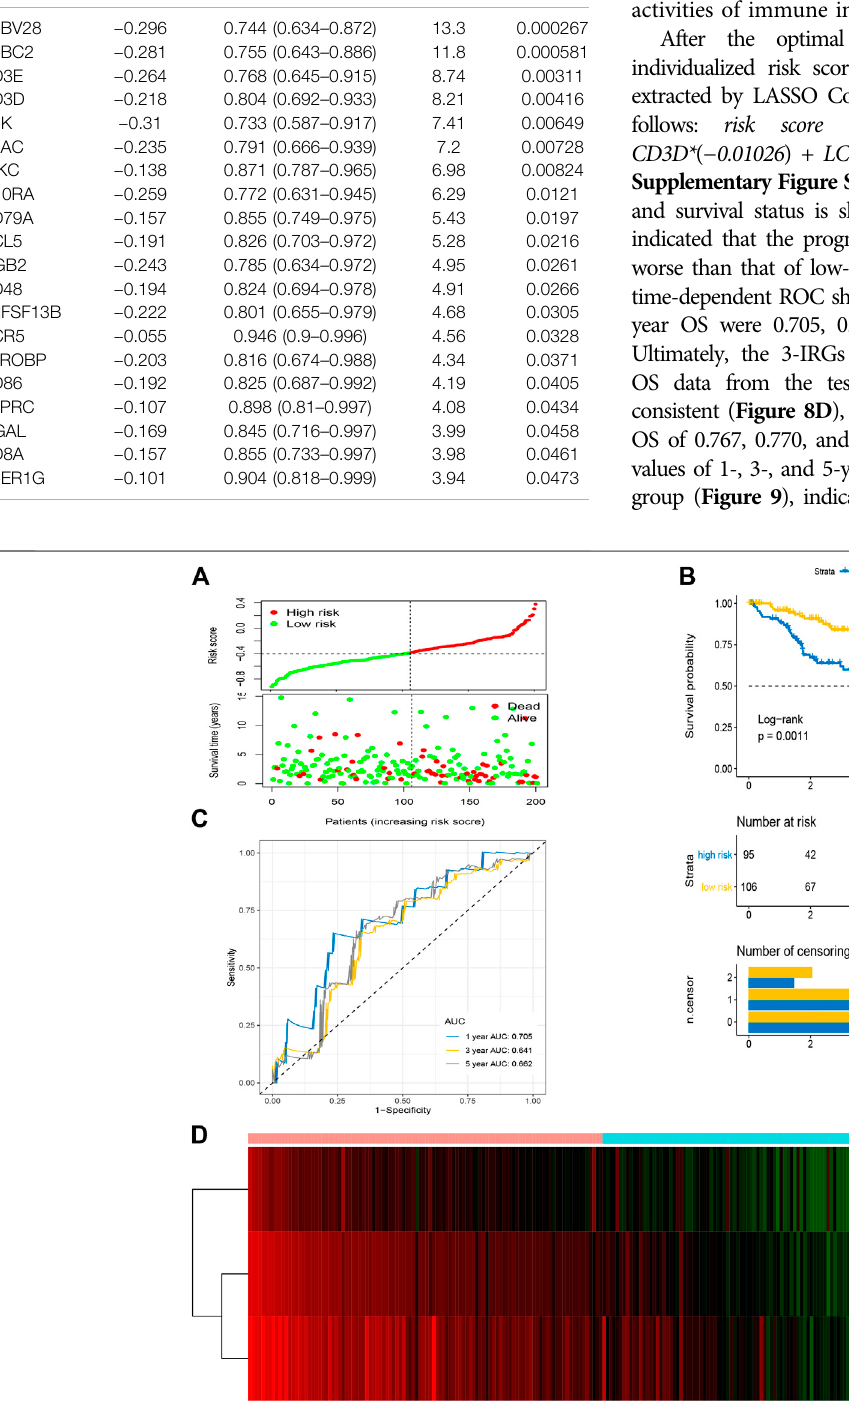
FIGURE7| Construction ofprognosticsignaturebasedonfour hubIRGsintraininggroup. (A) Thedistributionofriskscoresandsurvivalstatus betweenlow- and high-risk groups, and mean level of risk score was set as the cut-off value. (B) The overall survival analysis of patients in two subgroups. (C) ROC curve analysis for the prediction of1-, 3-, and 5-year OSas the de fi ning point of thefour-hubIRGs signature. (D) Heatmap offour prognostic IRGs. IRGs, immune-related genes; ROC curve, receiver operating characteristic curve; OS, overall survival.